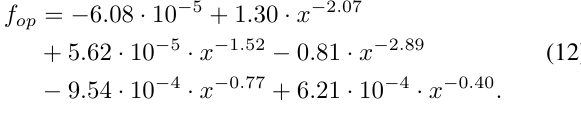
Fig. 2 illustrates experimental and optimized curves ob- tained with F aval = 1 . 25 · 10 − 2 . In the same figure there is a cut at the point 75 showing the difference between both curves with instantaneous error of about 10 − 4 .